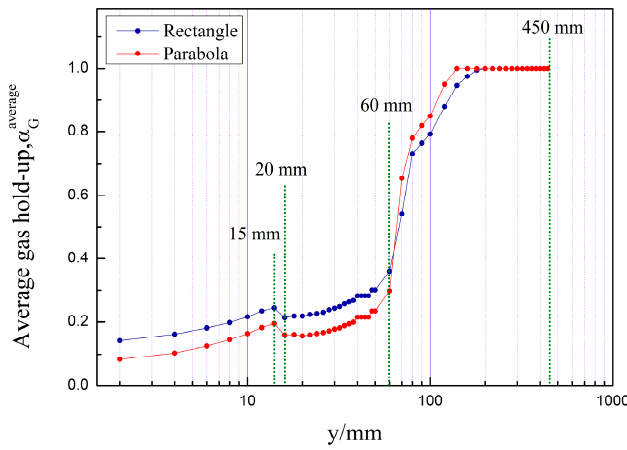
Figure 11. Average gas hold–up at different heights.